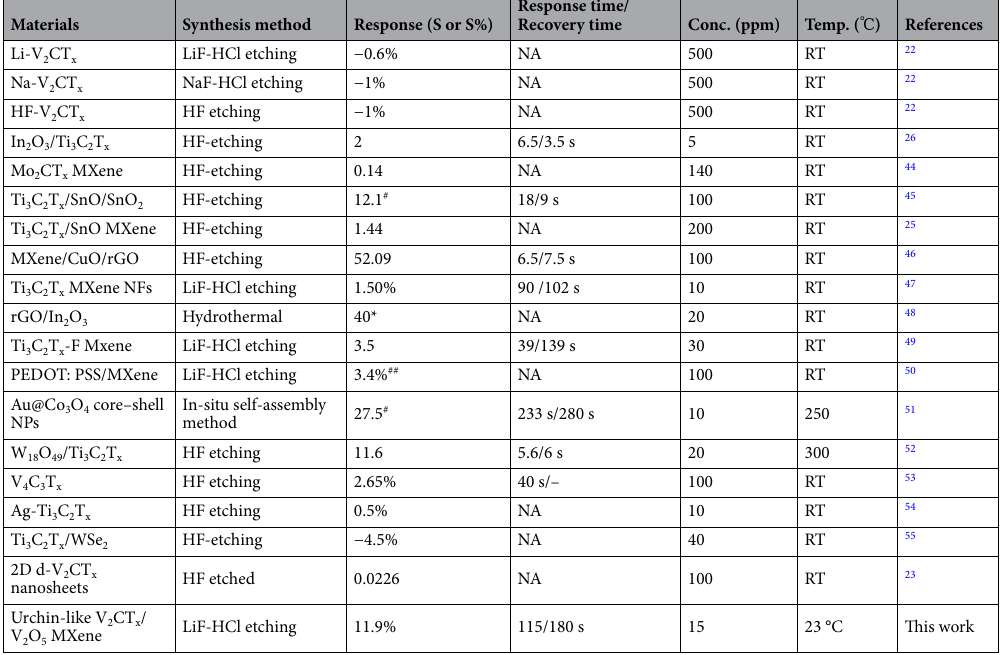
Table 1. A summary of recent studies on various acetone-sensing-based chemiresistive gas sensors. *S = R a /R g , # S =